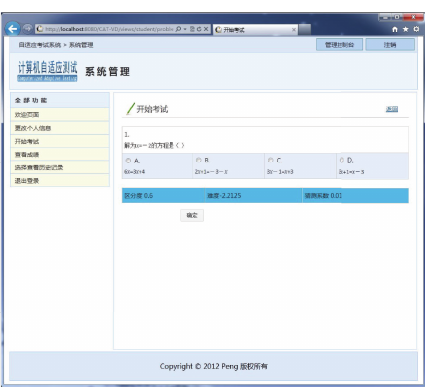
Figure 4: Log home.